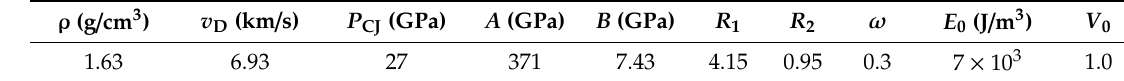
Table 8. Parameters of TNT charge.